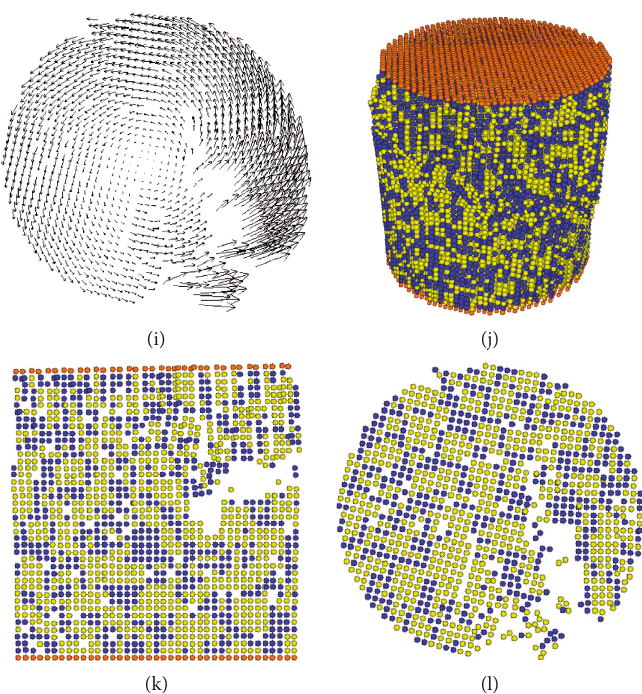
Figure 18: Ending stage of the loading period (model failure). (a) Stress distribution (entire model). (b) Stress distribution (vertical section). (c) Stress distribution (transverse section). (d) Contact distribution (entire model). (e) Contact distribution (vertical section). (f) Contact distribution (transverse section). (g) Displacement field (entire model). (h) Displacement field (vertical section). (i) Displacement field (transverse section). (j) Crack distribution (whole model). (k) Crack distribution (vertical section). (l) Crack distribution (transverse